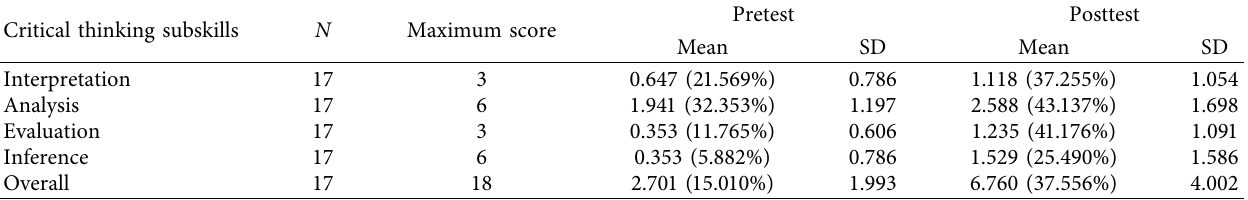
Table 6: Low-achieving: means and standard deviations for and pre- and post-test scores.